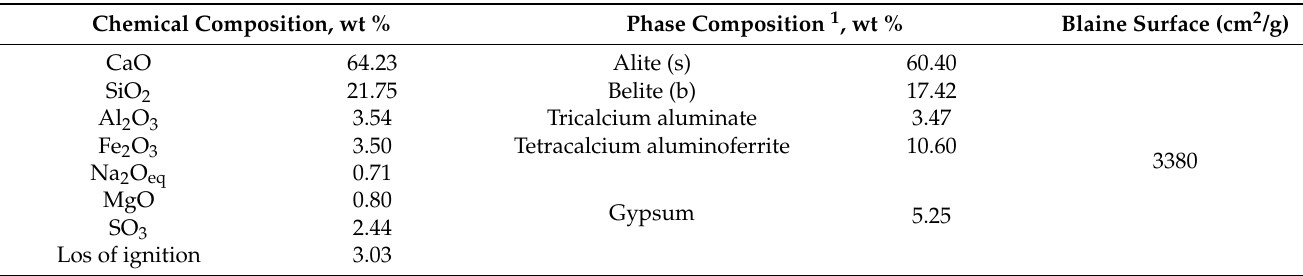
Table 2. Composition and specific surface of Portland cement.